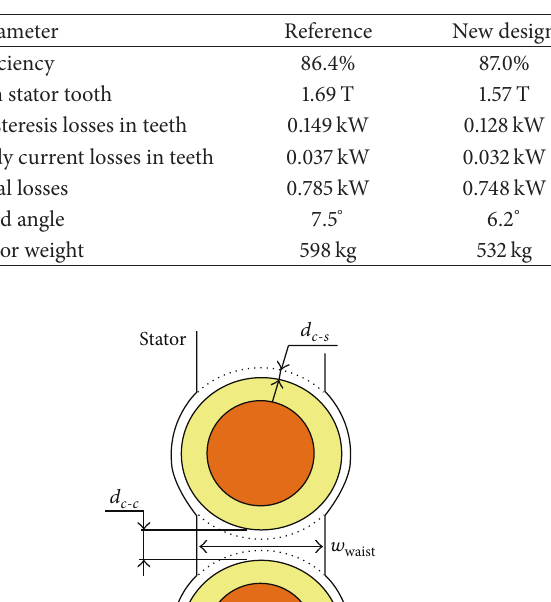
Table 3: Reference machine performance at its nominal operating point compared with the suggested improved design.